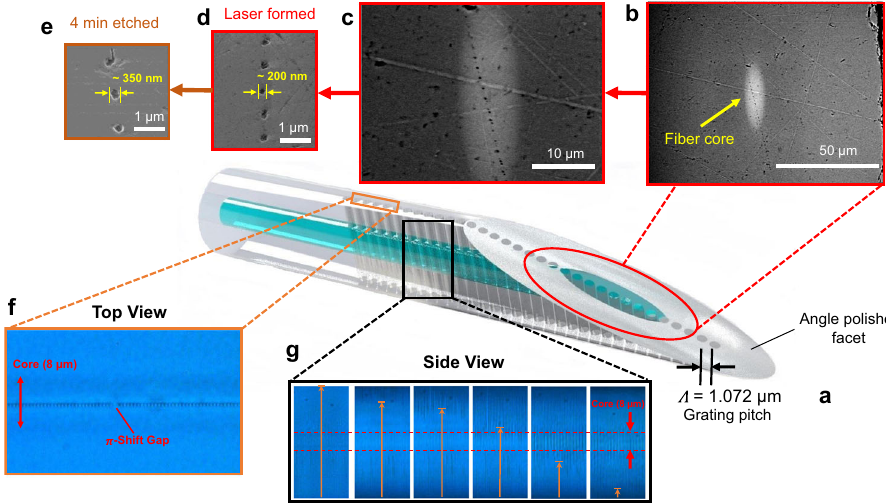
Fig. 3 Morphological characterisation of the nanoholes with SEM and optical microscopy images. Schematical view of a nanohole embedded optical fi bre with angled facet ( a ) and supporting microscopic imaging ( b – g ). Optical microscopy of the nanohole array showing the central alignment of the array to the core in the end view ( f ) and a time sequence (left to right) of evaporating isopropanol with menisci level (yellow arrow) moving downward in side views of the nanoholes ( g ). Under increasing magni fi cation, SEM images of the angled fi bre facet ( a – d ) unveil open nanoholes having formed continuously and uniformly (~200 nm diameter) through the core (white oval zone) and cladding without a breakthrough on the tight 1.072 µ m periodic spacing. SEM ( e ) shows the hole diameter expanded to 350 nm after 4 min of chemical etching (5%